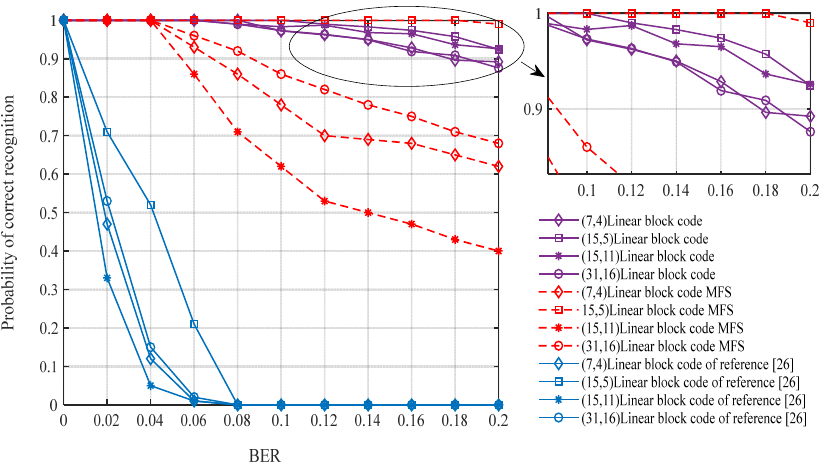
Figure 14. Comparison of algorithms under error conditions. (7,4), (15,5), (15,11), (31,16) Linear block code (in blue color) Li et al. [26].